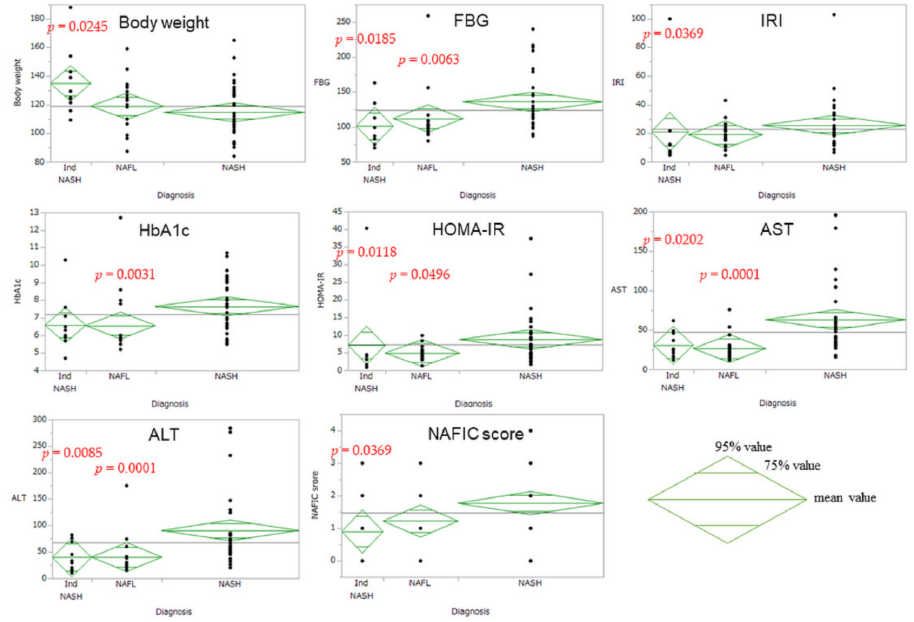
Figure 4. Upper and lower vertical angles of rhombuses indicate the 95% value. The control arm is the NASH group; therefore, if the vertical angles are not overlapping, it means significant differences compared to the NASH